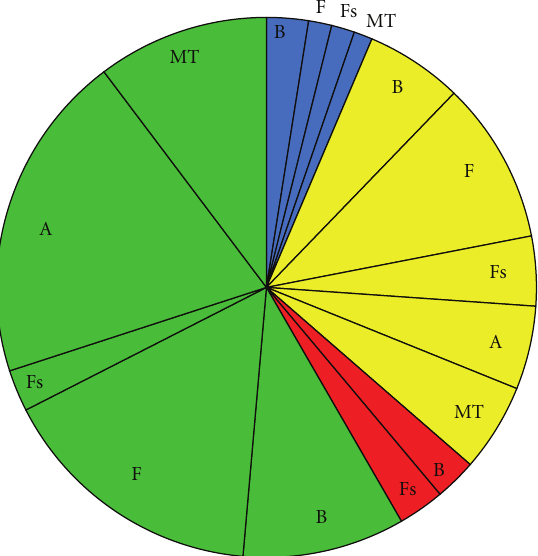
Figure 6: Pie chart representing the proportion of impacts for each ecosystem component for Impact scenario i5, floating mooring tidal turbine projects, categorized by whether the e ff ect is positive (blue), minor negative (green), moderate negative (yellow), or major negative (red). B = Benthic habitat and resources; F = Fish; Fs = Fisheries; A = Avian species; MT = Marine mammals and sea turtles.